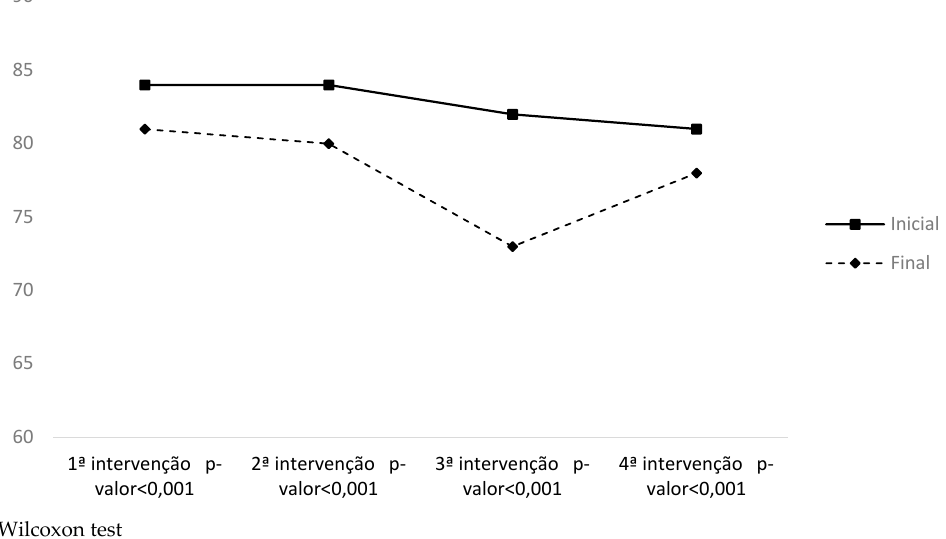
Figure 3. Median values of diastolic blood pressure (DBP) before and after the four interventions in the IG (Raja yoga meditation).